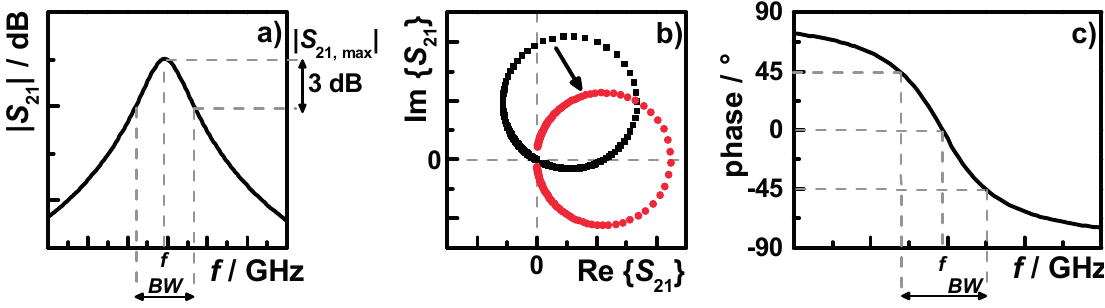
Figure 6. ( a ) A resonance peak in detail, showing the resonant frequency f , 3 dB bandwidth BW , and maximum peak height | S 21, max | determined by a scalar data analysis approach; ( b ) the corresponding resonance circle (black) and the canonical transformed circle (red); and ( c ) the frequency-phase relation of the transformed resonance circle for the complex analysis approach for f and BW .